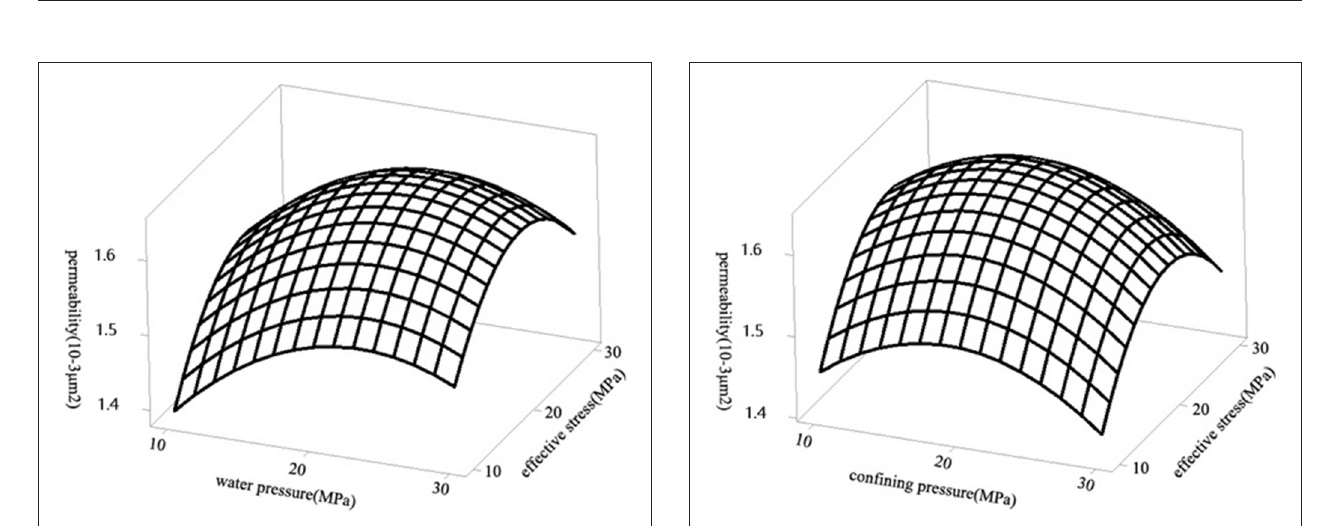
FIGURE 3 | Flow chart of permeability measurement experiment.